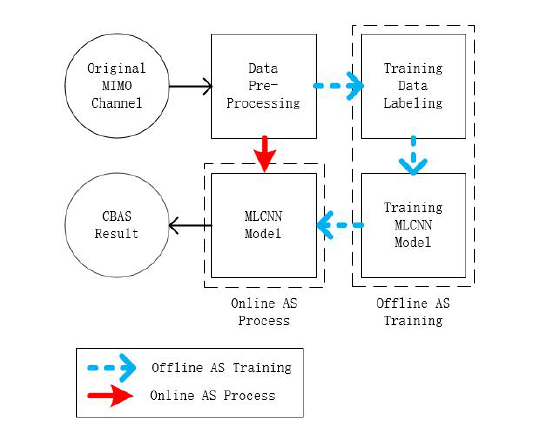
Figure 1. The block diagram of the MLCNN-aided